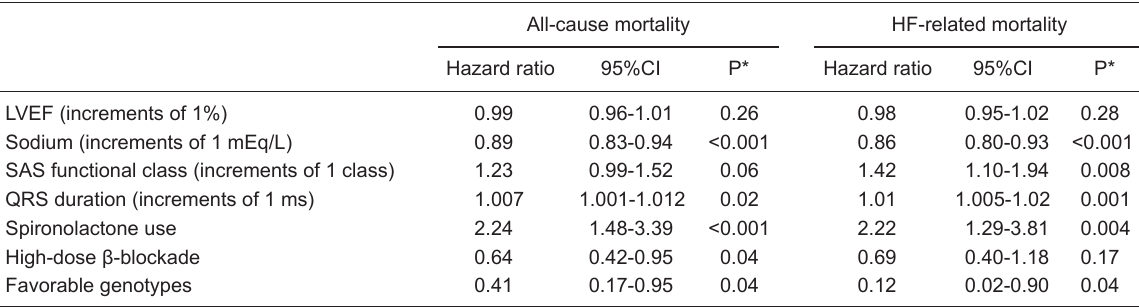
Table 3. Cox proportional hazard model for all-cause and heart failure (HF)-related